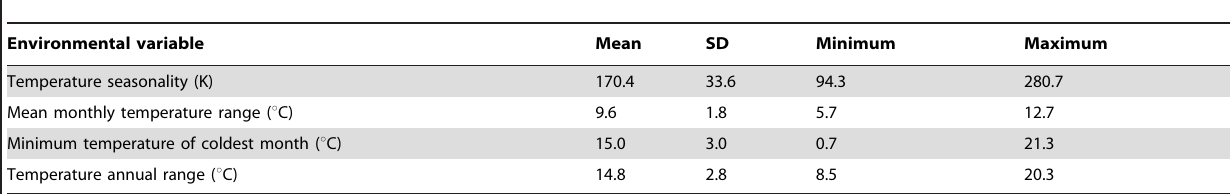
Table 2. Descriptive statistics of the most limiting environmental variables for maned sloth ( Bradypus torquatus ) in areas of high probability of suitable conditions (Threshold . 0.658), predicted by the continuous ensemble model of the potential geographic